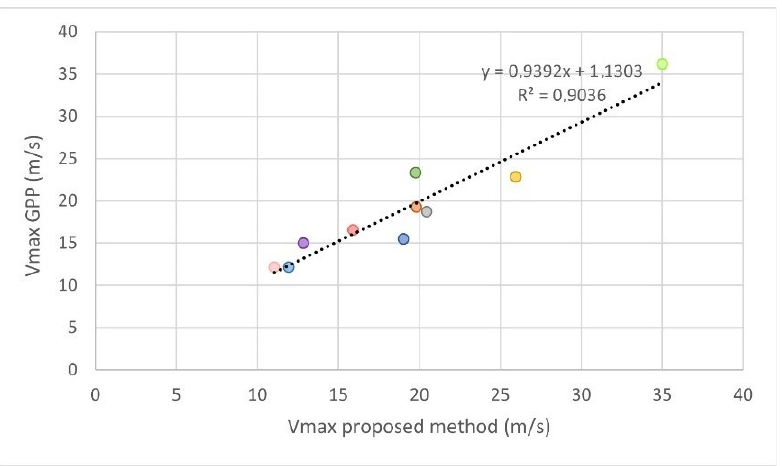
Figure 10. Graph of correlation between the proposed method and GPP model maximum velocity values for ten selected rockfalls. Each point shown in the graph represents the maximum velocity value of a rockfall computed with the two methods.